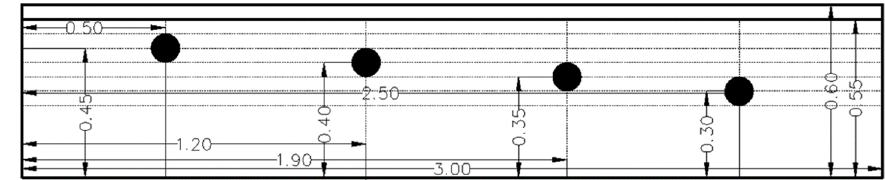
Figure 5. Schematic diagram of a SWB model with different burial depths. Unit: Meters.